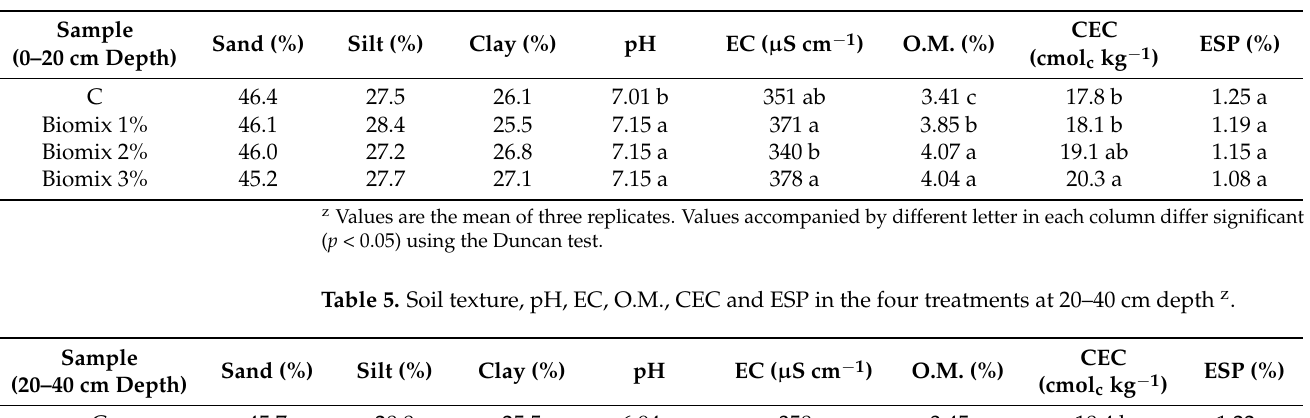
Table 4. Soil texture, pH, EC, O.M., CEC and ESP in the four treatments at 0–20 cm depth z .